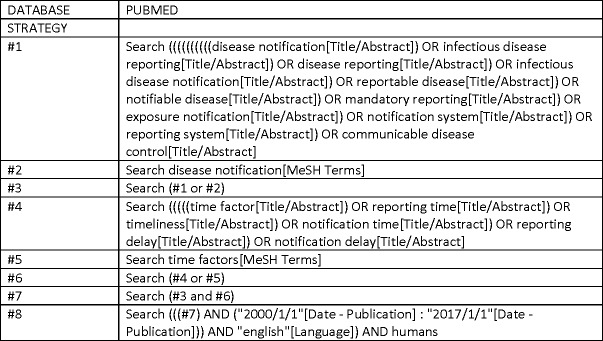
Full electronic search strategy for pubmed.